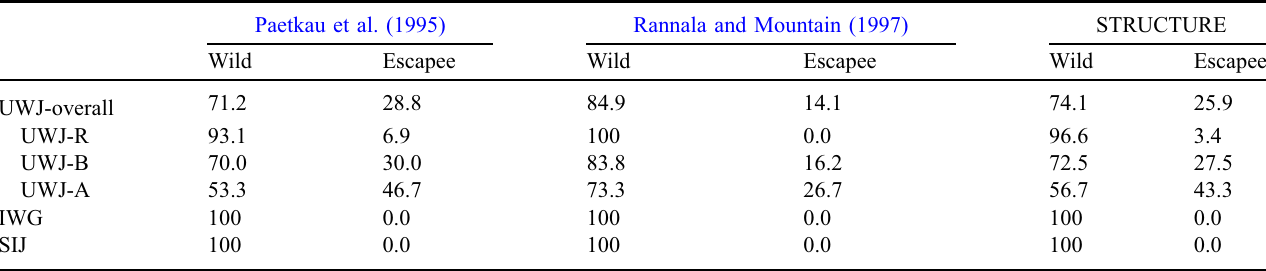
Table 4. Percentage of wild and escapees resulted by three methods of assignment. Paetkau et al. (1995) Rannala and Mountain